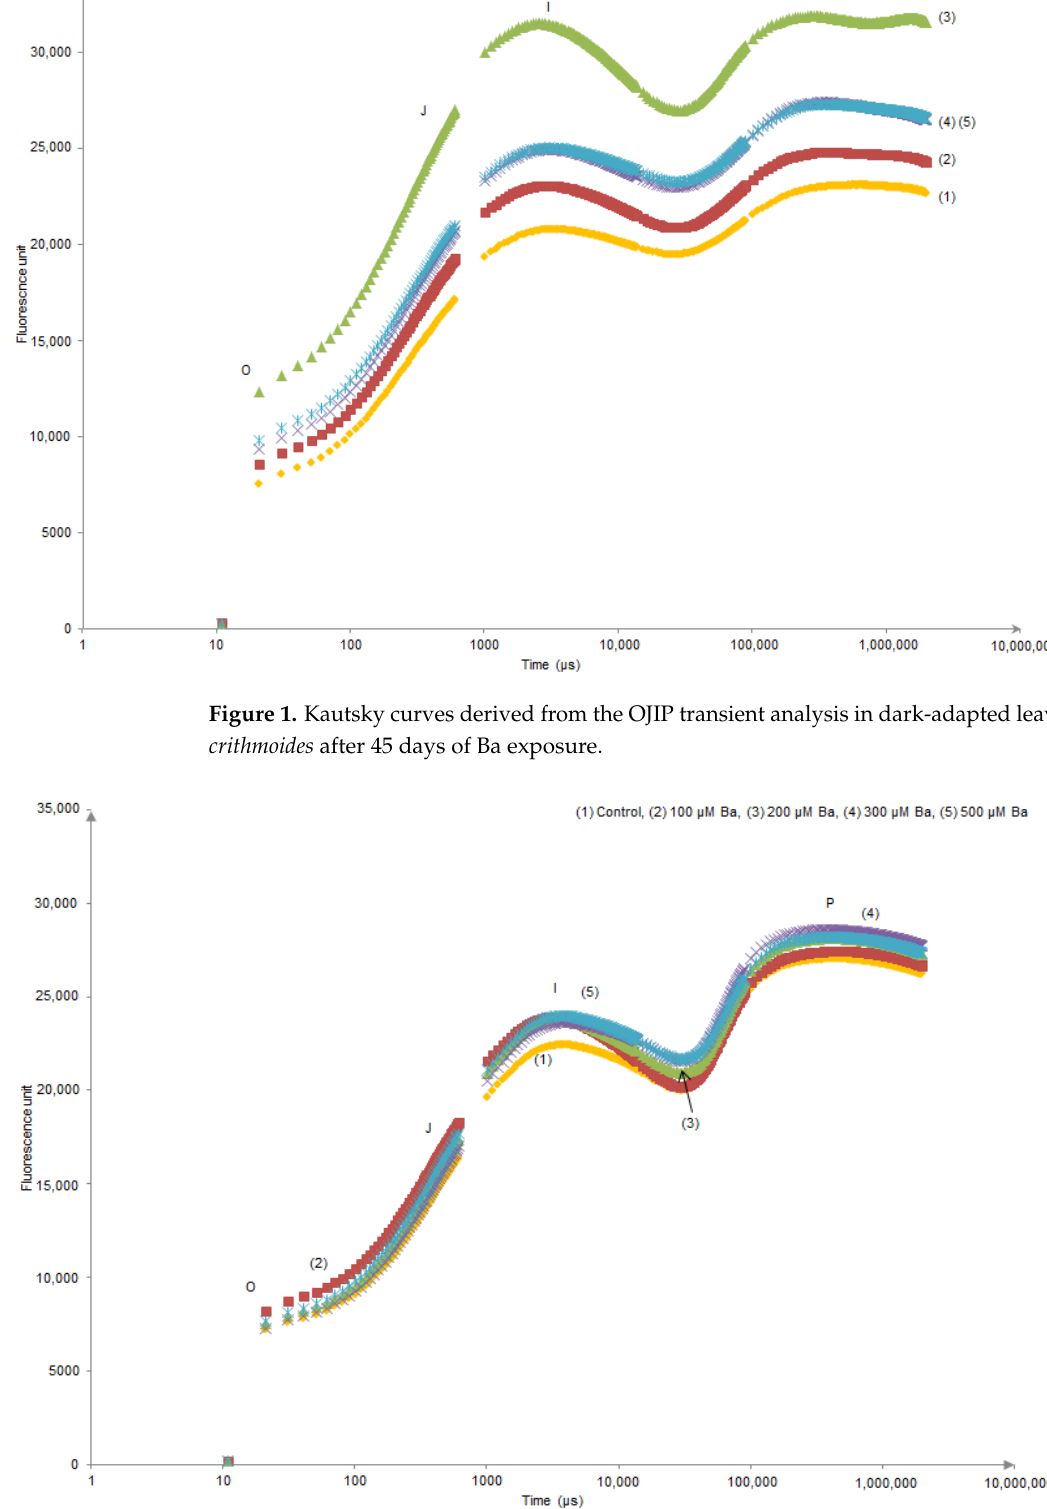
Figure 2. Kautsky curves derived from the OJIP transient analysis in dark-adapted leaves of Helianthus annuus after 45 days of Ba exposure.